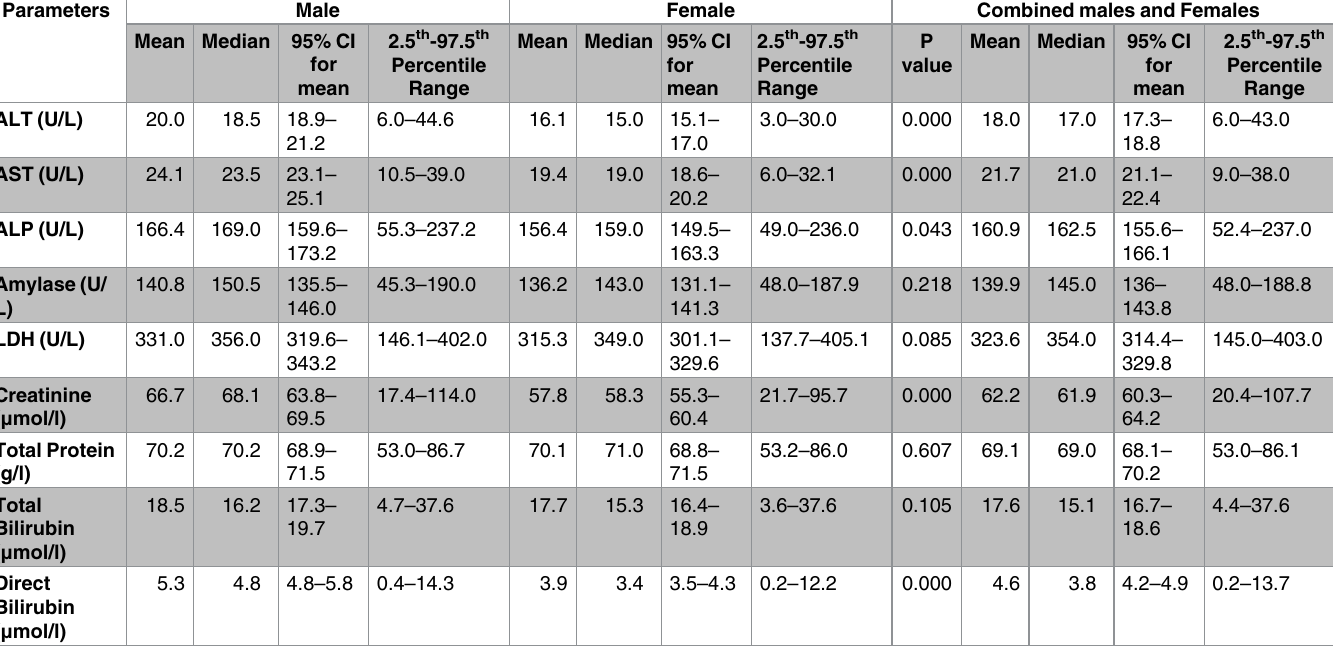
Table 2. Mean, median, 95% CI for mean and 2.5 th -97.5 th percentile of clinical chemistry referencevalues in relation to sex of healthy adults in Goj- jam, Zones, AmahraNational Regional State, Northwest Ethiopia.